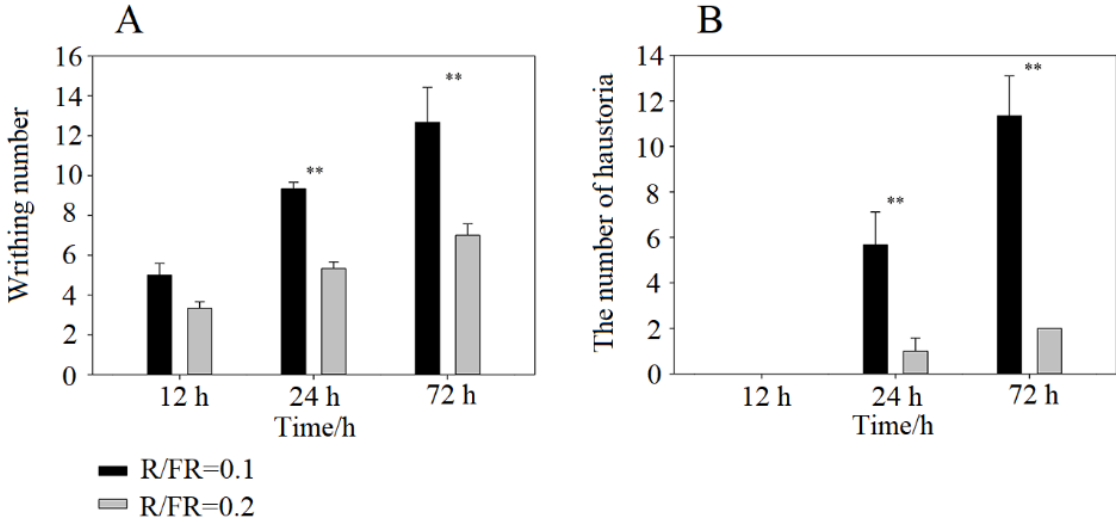
Figure 2. Writhing number ( A ) and haustoria number ( B ) formed by Cuscuta chinensis under differ- ent R/FR ratios at 12 h, 24 h and 72 h irradiation. ** indicate p < 0.01.